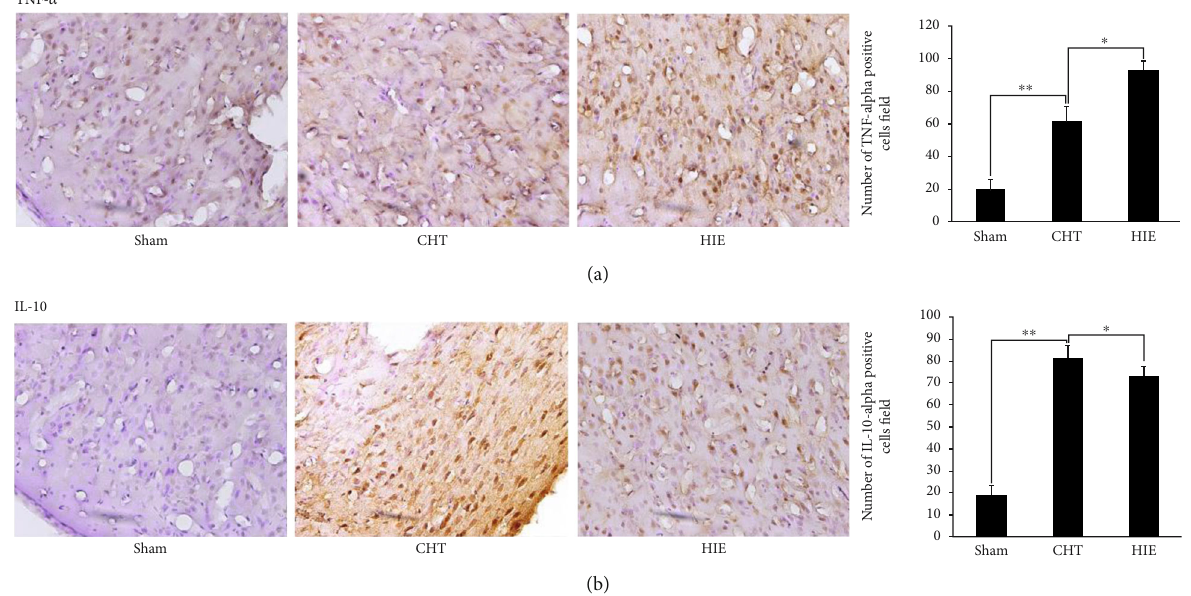
Figure 4: Chinese Tuina improved the neuroin fl ammatory reaction in rats with HIE. (a) Representative photomicrographs of TNF- α - positive cells (40x) and the quantitative results of the number of positive cells; (b) representative photomicrographs of IL-10-positive cells (40x) and the quantitative results of the number of positive